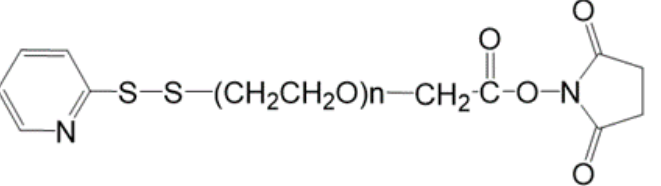
Figure 10. Molecular structure of OPSS-PEG-NHS. (Reproduced with permission from [33],